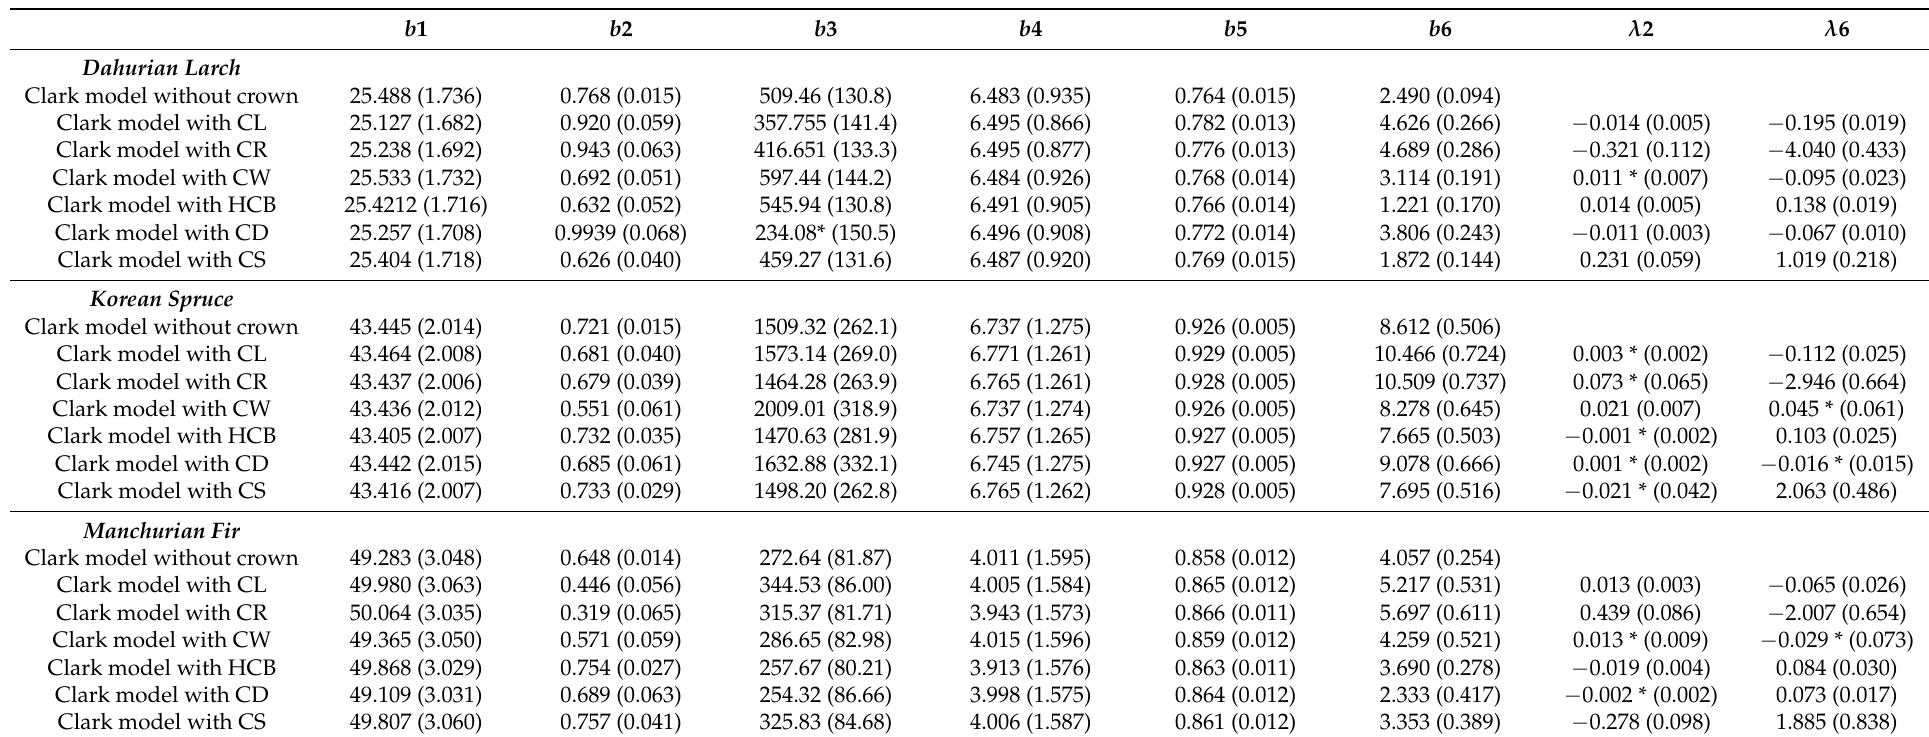
Table 3. Parameter estimates (standard errors in parentheses) of the Clark model with and without crown